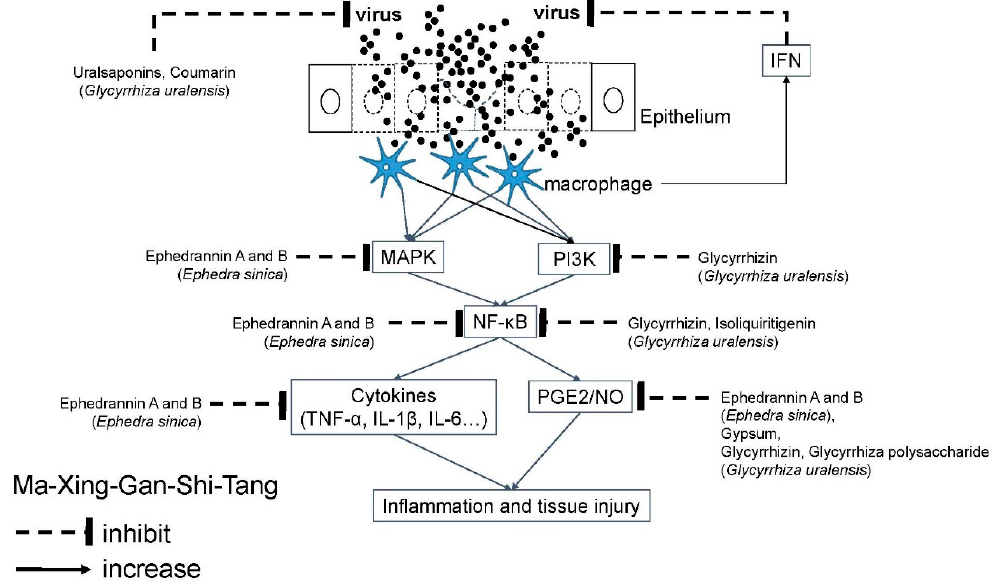
Figure 4. Molecular mechanism of Ma-Xing-Gan-Shi-Tang against airway viral infections. Airway viruses infect the epithelium to cause tissue injury. Ma-Xing-Gan-Shi-Tang contains several active molecules to inhibit viral replication and signal transduction of inflammatory response. Akt: Serine/threonine protein kinase B (PKB); COX: Cyclooxygenase; ERK: Extracellular signal-regulated kinase; IL: Interleukin; iNOS: Inducible nitric oxide synthases; JNK: c-Jun N-terminal kinases; MAPK: Mitogen-activated protein kinase; NF- κ B: Nuclear factor-kappa B; NO: Nitric oxide; PG: Prostaglandin; PI3K: Phosphoinositide 3-kinase; PMN: Polymorphonuclear neutrophils; TNF: Tumor necrotic factor.